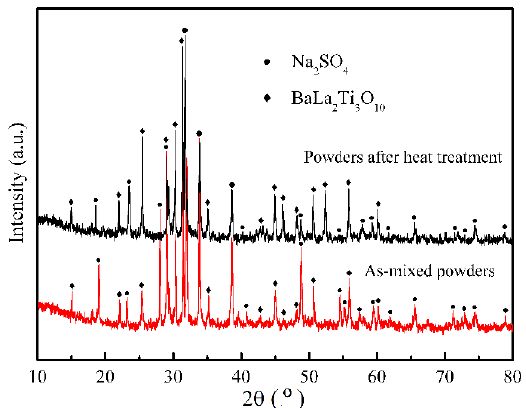
Figure 5. XRD patterns of the as-mixed BaLa 2 Ti 3 O 10 and Na 2 SO 4 powders and the mixed powders after heat treatment at 900 °C for 4 h.